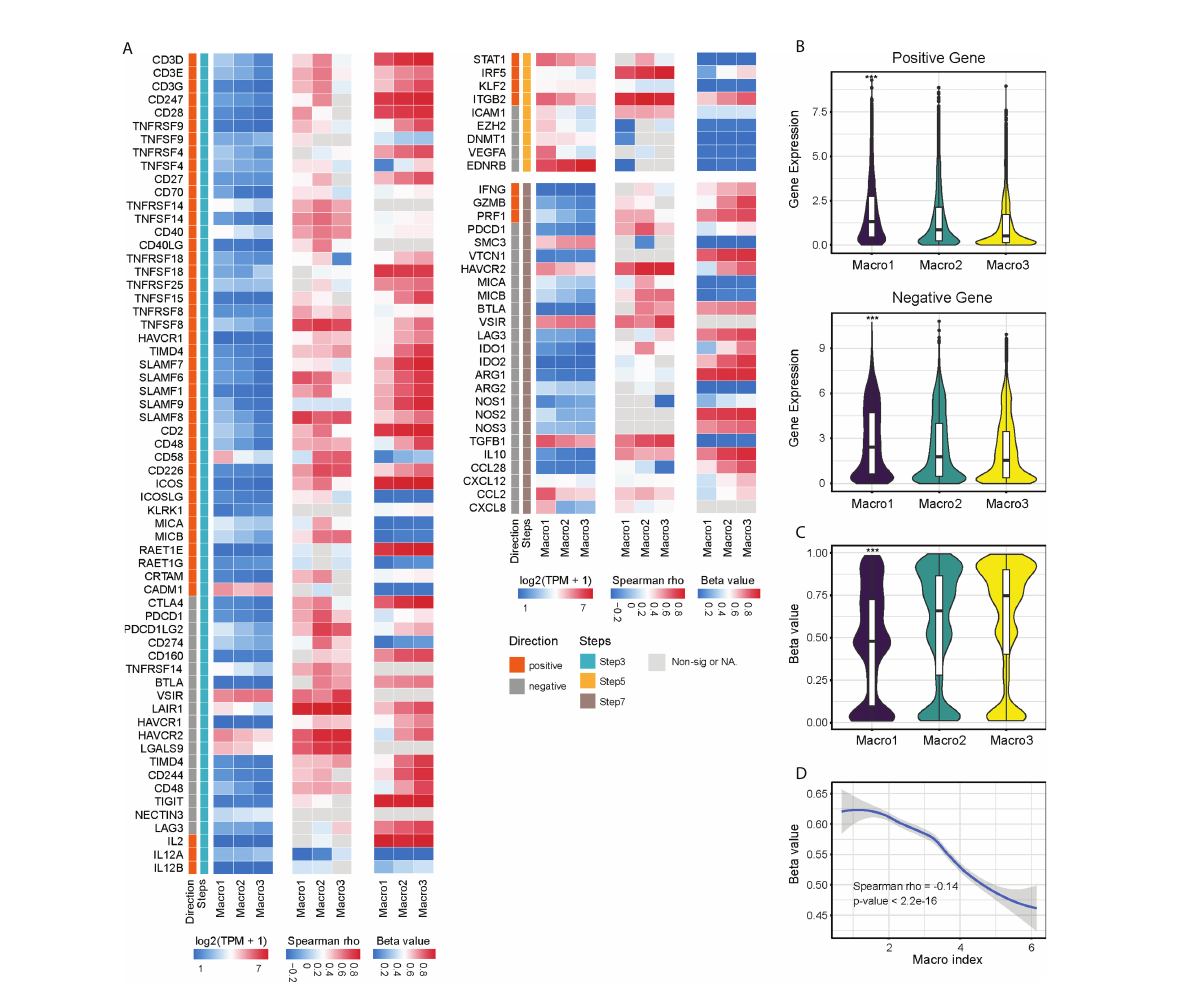
FIGURE 4 Immunological characteristics associated with Macro index-based groups. (A) Expression, methylation of immune-related genes and correlation with Macro index. Genes assigned to the TIP step3 (T cell priming and activation), step5 (in fi ltration of immune cells into cancer), and step7 (cancer cell killing) were included. (B) The overall expression of immune-activating and immune-suppressing genes in each group. (C) The overall methylation levels of these genes in each group. (D) Spearman correlation analysis of the Macro index with the overall gene methylation level. ***p <